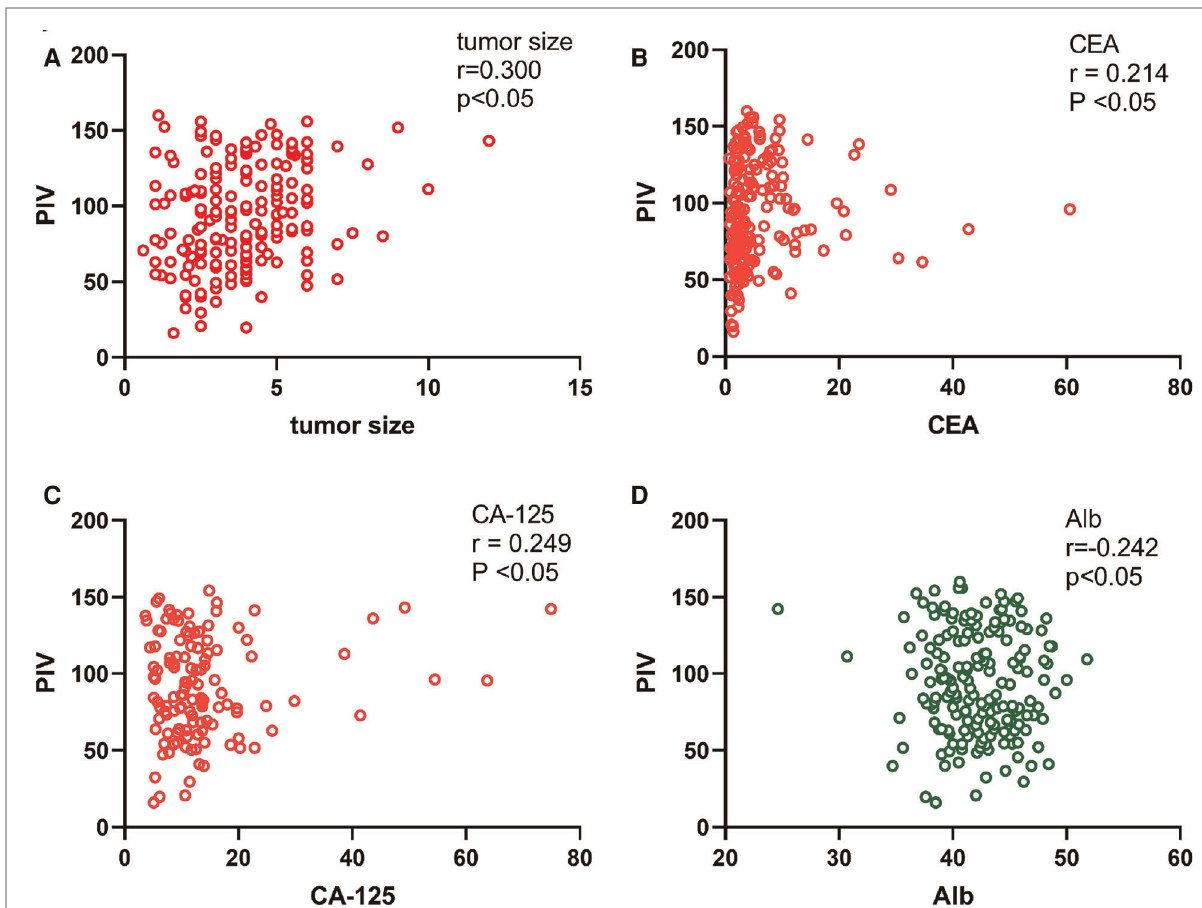
FIGURE 1 Correlation between PIV and tumor size, CEA, CA-125, Alb. Correlation between PIV and tumor size ( A ); Correlation between PIV and CEA ( B ); Correlation between PIV and CA-125 ( C ); Correlation between PIV and Alb ( D